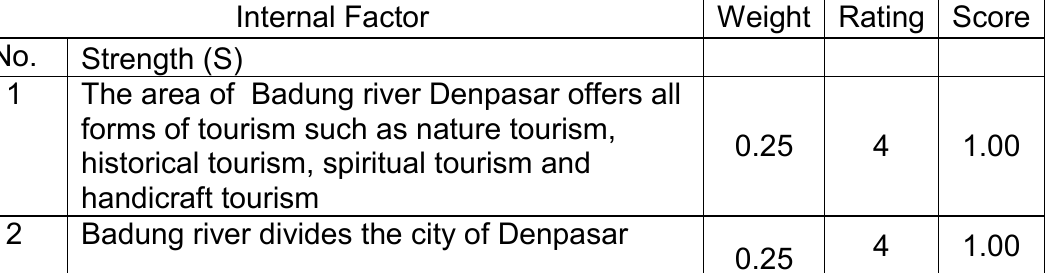
Table 1. IFAS-Weighted, Rating, and